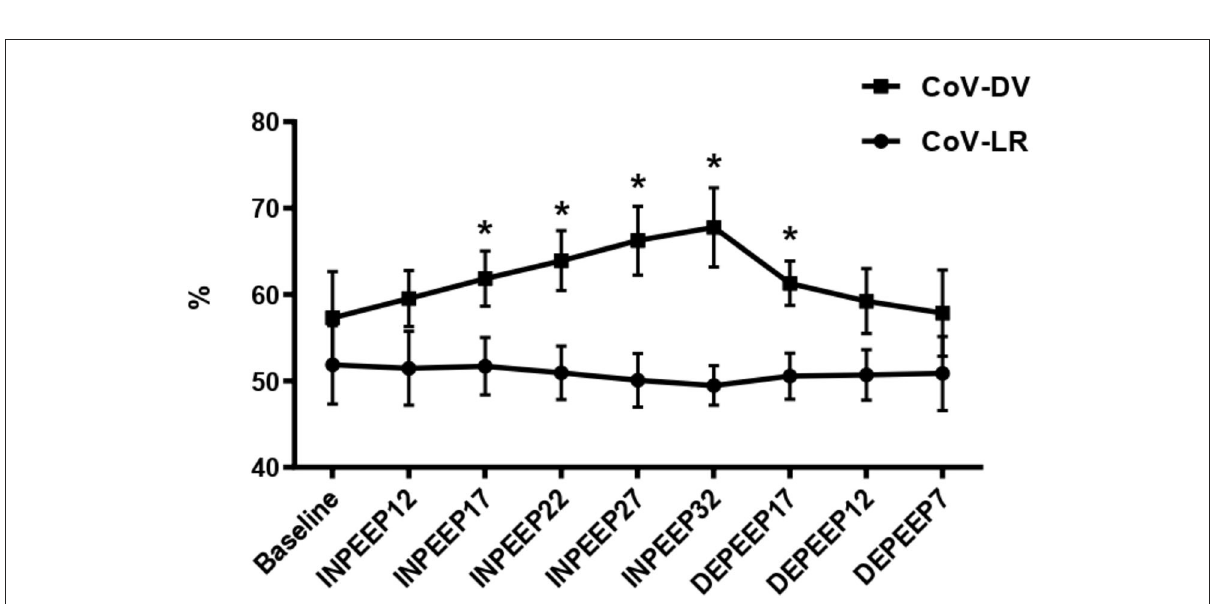
FIGURE2 Center of ventilation dorsoventral (closed square) and center of ventilation left–right (closed circle) represented by mean ± standard deviation during recruitment maneuver for PEEP titration. PEEP: positive end-expiratory pressure; Baseline: 7 cmH 2 O of PEEP; INPEEP12: PEEP 12 cmH 2 O increase; INPEEP17: PEEP 17 cmH 2 O increase; INPEEP22: PEEP 22 cmH 2 O increase; INPEEP27: PEEP 27 cmH 2 O; INPEEP32: PEEP 32 cmH 2 O increase; DEPEEP17: PEEP 17 cmH 2 O decrease; DEPEEP12: PEEP 12 cmH 2 O decrease; DEPEEP7: PEEP 7 cmH 2 O decrease. * Statistically significantly different from the